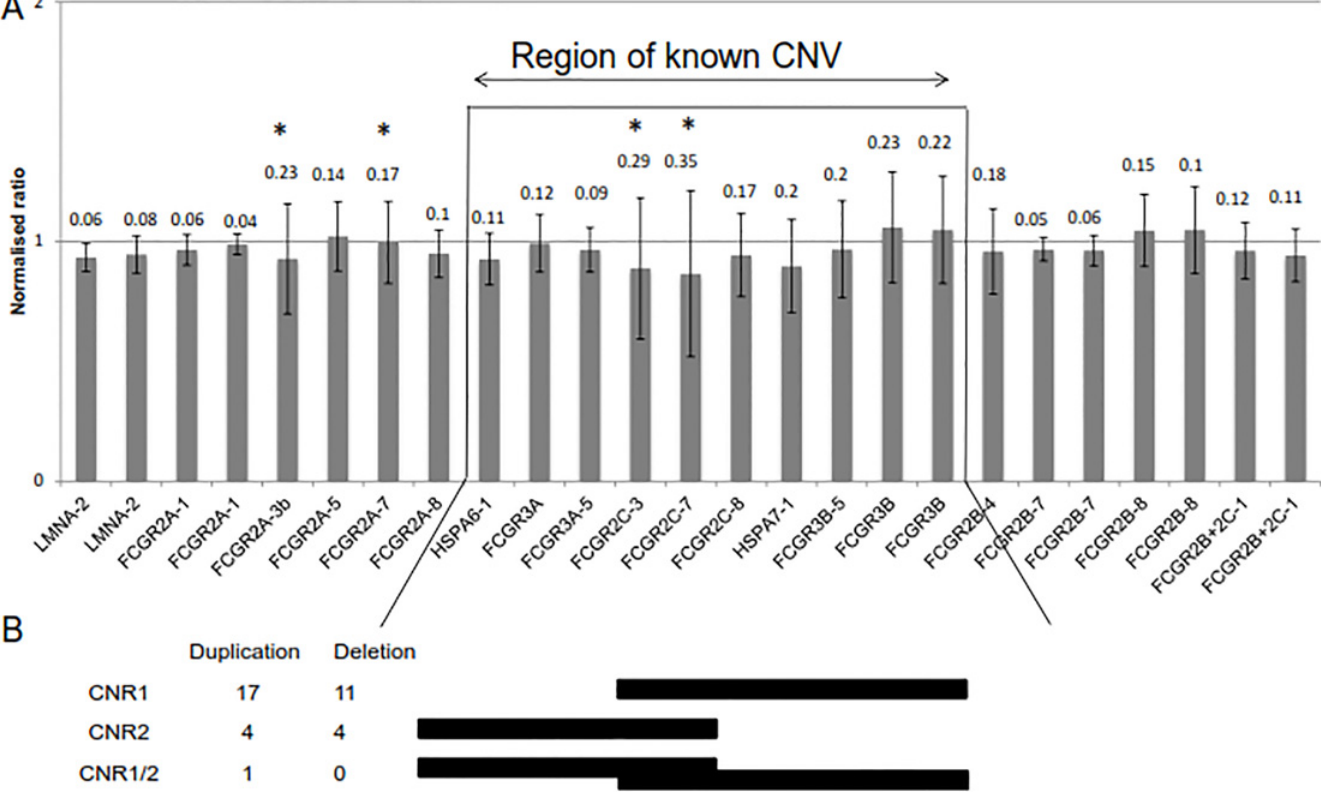
Fig 4. Performance of Fc γ R -targeted probes in healthy donors. (A) Probe binding performance was assessed by measuring the mean and SD of individual probes across our cohort of 164. Probes are represented in locus order. A normalised peak height ratio of 1 represents a diploid copy number. Error bars represent the mean +/- SD and the SD is shown above each probe. (B) Copy number regions (CNRs) 1 and 2 in healthy donors with observed numbers of duplication and deletion events. One donor showed CNV likely to include two duplications; one of the distal part containing FCGR2C and FCGR3B (CNR1) on one chromosome and one of the proximal part containing FCGR3A and FCGR2C (CNR2) on the other chromosome. * Probes in which the variability is a result of known genomic SNPs targeted by the